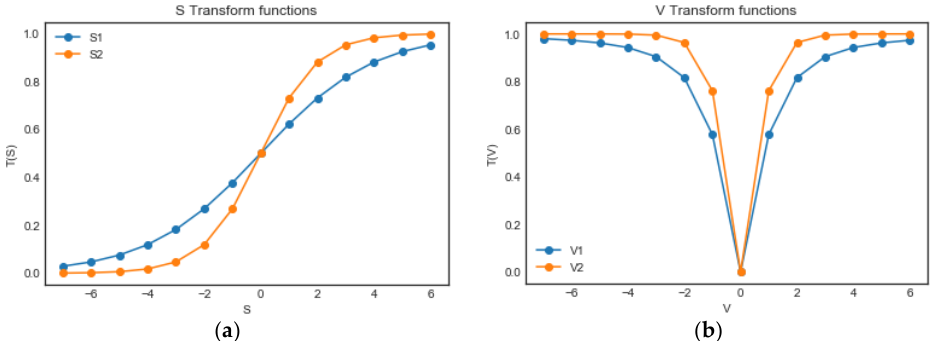
Figure 3. Graphical chart of the values of ( a ) the 𝑆 transform function for both 𝑆1(𝑖𝑛𝑑 𝑖 ) and 𝑆2 (𝑖𝑛𝑑 𝑖 ) , and of ( b ) the 𝑇 transform functions for both 𝑇1 (𝑖𝑛𝑑 𝑖 ) and 𝑇2 (𝑖𝑛𝑑 𝑖 ) . The aim of applying these transform functions is to ensure that they can help transfer the composition of feature positions in an individual to either 0 or 1. Additionally, these functions can increase the probability of changing the natural composition of that individ- ual, so that they become a potential solution for solving feature selection problems. This is illustrated using Equations (8) and (9). The first part of the two equations controls the selection of either the S1 or S2 function when applying the S-function and the use of either T1 or T2 when applying the V-function. A determinant factor is used to guide this deci- sion, so that if 𝑟𝑎𝑛𝑑(0|1) , the function generates 1, and the S2 or T2 function is called as appropriate; otherwise, the S1 or T1 function is called. In the second part of the two